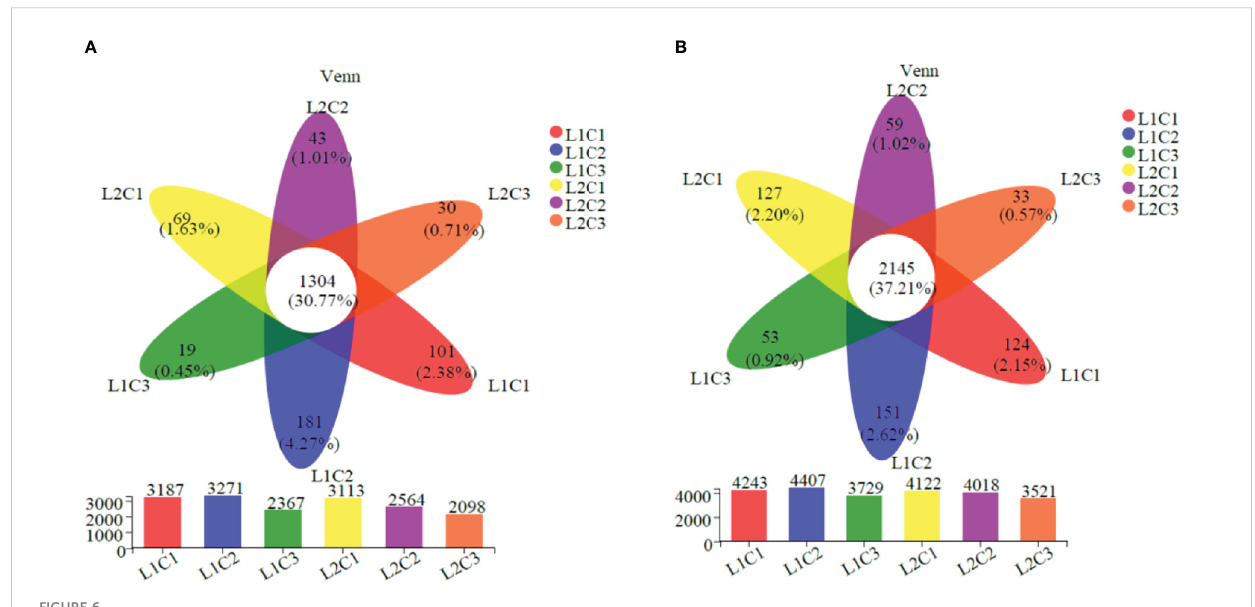
FIGURE 6 OTUs classi fi cation of soil bacteria. (A) Spring (B)